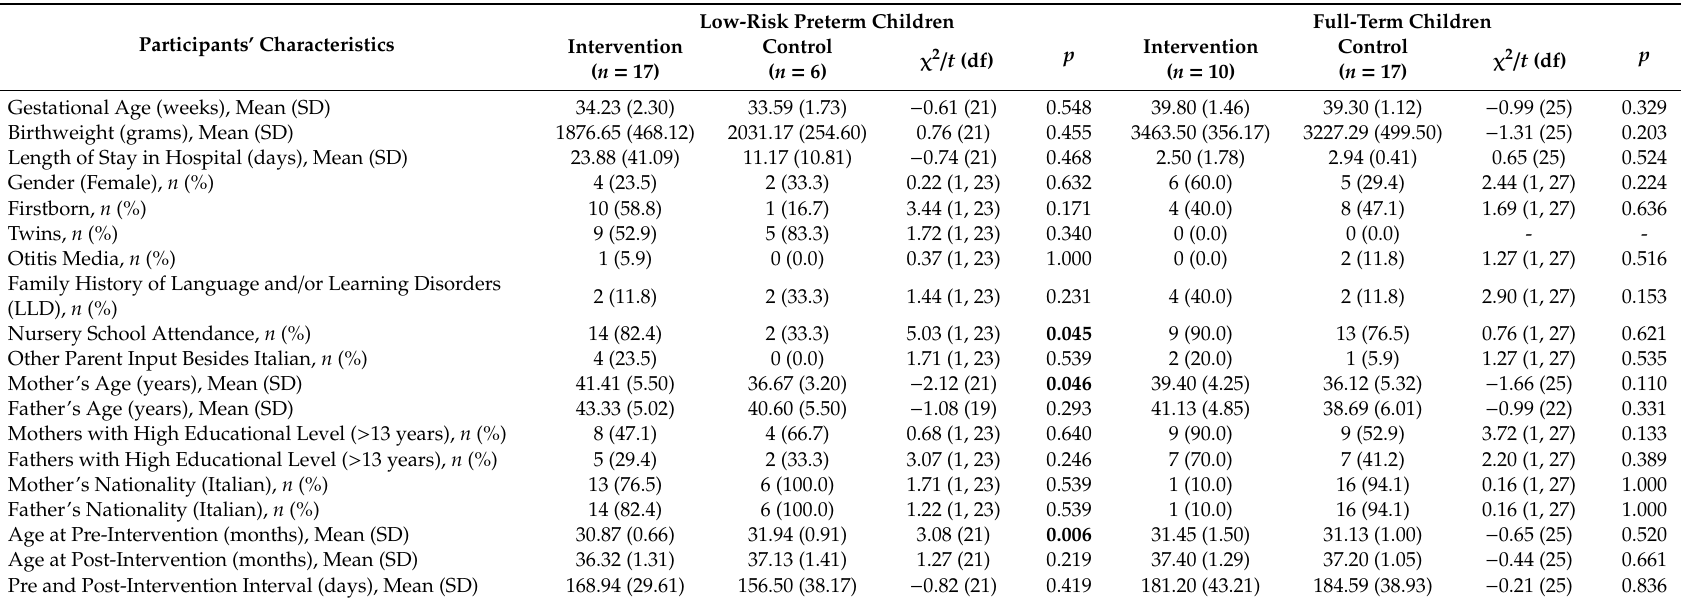
Table 2. Sociodemographic characteristics of participants within the low-risk preterm and full-term